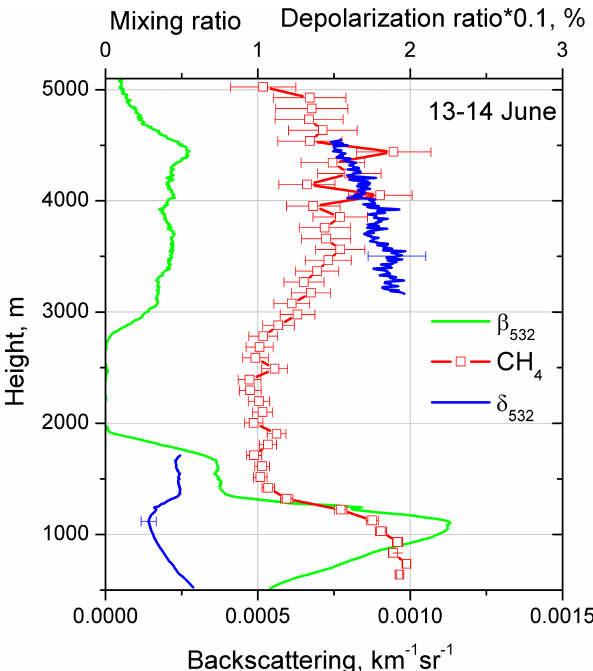
Figure 7. Aerosol backscattering coefficient β 532 , particle depo- larization δ 532 and CH 4 mixing ratio on 13–14 June 2018 for the temporal interval 22:00–02:00UTC. Values of δ 532 are multiplied by a factor of 0.1. Mixing ratios are not calibrated and the value 1.0 corresponds to approximately